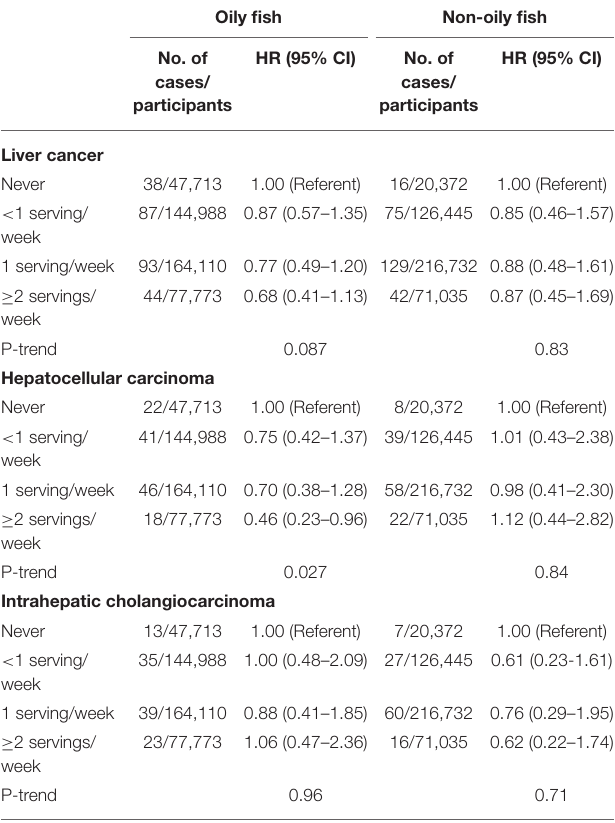
TABLE 3 | Association of fish intake with risk of liver cancer and its major histological subtypes. Oily fish Non-oily